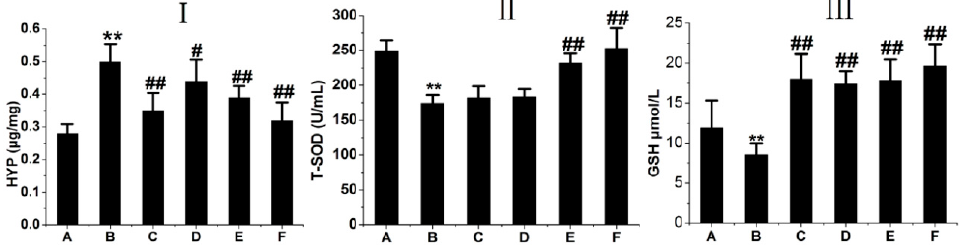
Figure 4. ( I ) lung tissue HYP (hydroxyproline) level in rats; ( II ) serum T-SOD (Total superoxide